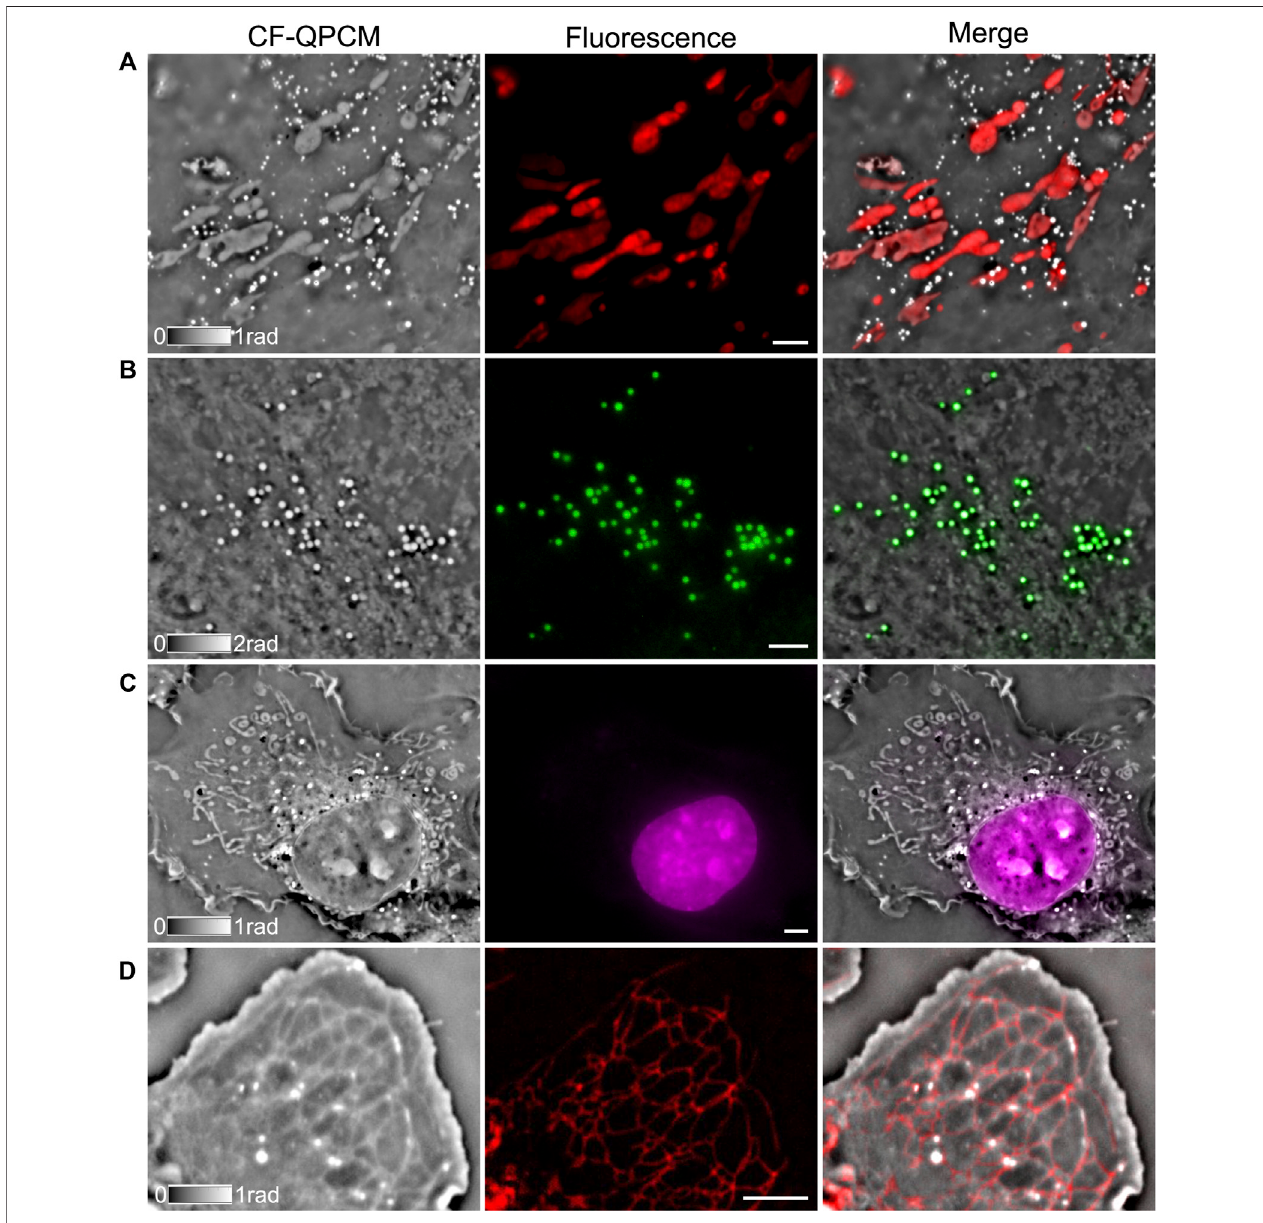
FIGURE3| Dual-modalityimagesofliveCos7cellsobtainedbycombiningCF-QPCMwithawide- fi eld fl uorescenceimagingmodule.CF-QPCM(grayimages)and wide- fi eld fl uorescence images (color images) of mitochondria (A) , lipid droplets (B) , cell nucleus with thin membrane (C) , and ER (D) . Scale bars in (A – D) represent 4 μ